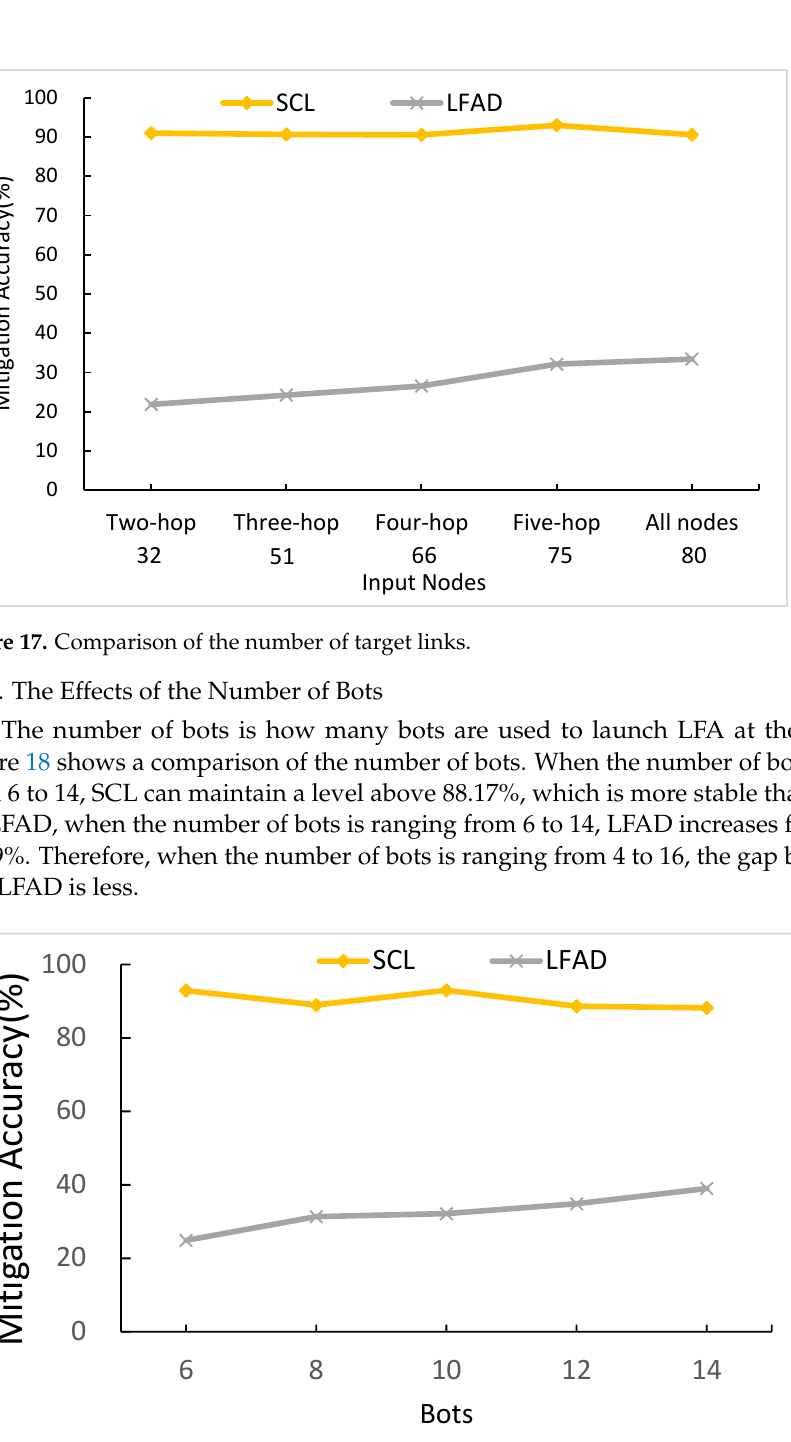
26 of 29 Figure 16. Comparison of the number of input links. 5.3.3. The Effects of the Number of Input Nodes The number of input nodes is the input dimensions. For example, if the number of input nodes is the two-hop, that means the input nodes of U t are 32 × 32. The hop means, with the target link as the center, the number of hops outward. Two-hop is to make target links as a center and go out according to a distance of two-hop links. As shown in Figure 17, there are five types of input nodes, and the number on each x -axis denotes the number of nodes in U t . Therefore, the input dimensions of each of them are 32 × 32, 51 × 51, 66 × 66, 75 × 75, and 80 × 80, respectively. When the number of input nodes is ranging from two-hop to all nodes, SCL can maintain a level above 90.51%, which is more stable than LFAD. As for LFAD, when the number of input nodes is ranging from two-hop to all nodes, LFAD increases from 21.88 to 33.42%. Therefore, when the number of input nodes is ranging from two-hop to all nodes, the gap between SCL and LFAD is less. The reason for this is that SCL learns from U t ; the higher the input nodes are, the